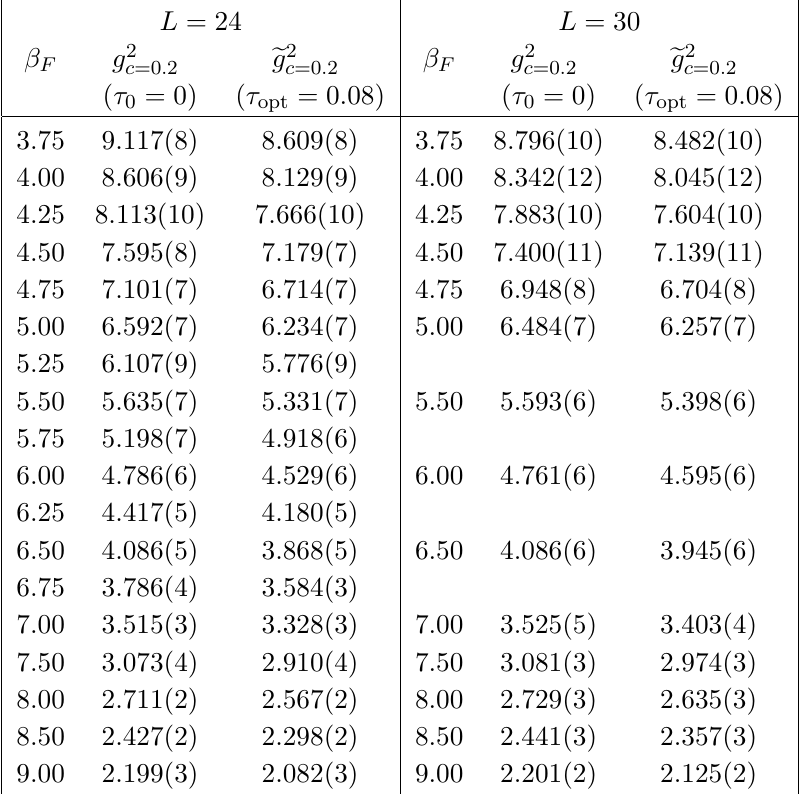
Table 13 . Renormalized gradient (cid:13)ow couplings in the c = 0 : 2 scheme for the 24 4 and 30 4 lattice ensembles used in this work, with columns as in table